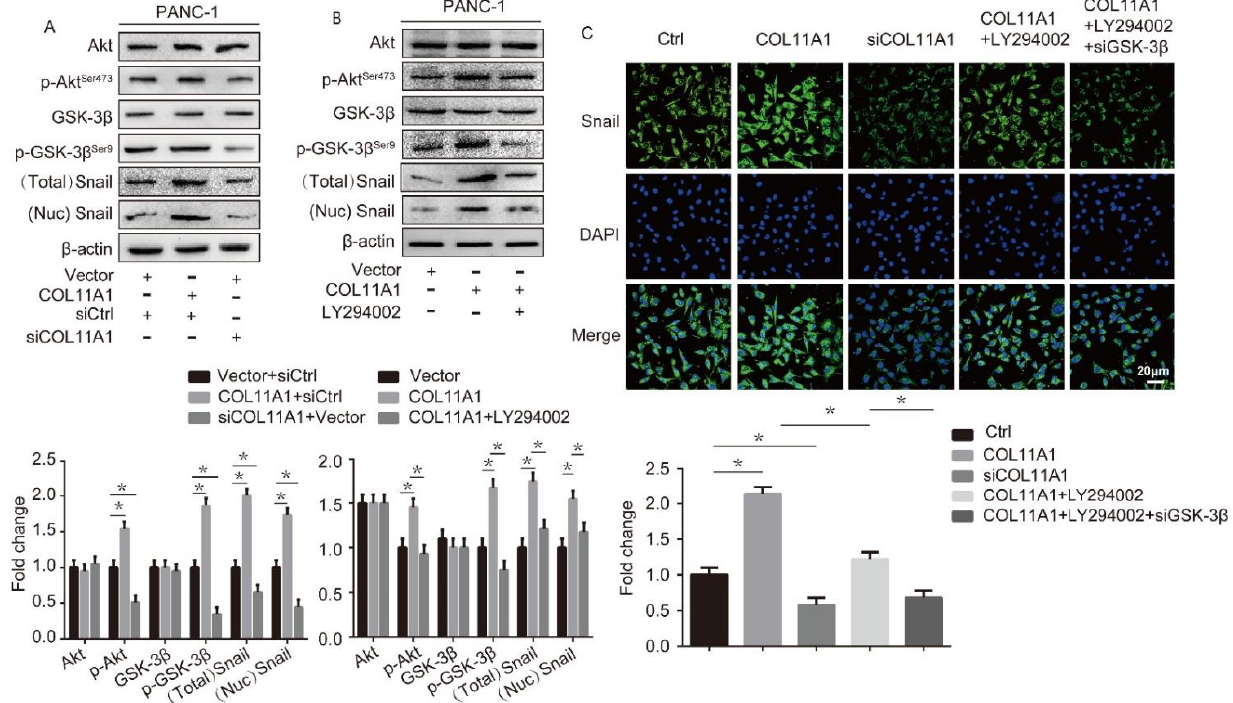
Figure 3. COL11A1 activated the serine-threonine kinase (AKT)/glycogen synthase kinase (GSK)- 3β/Snail signaling pathway : ( A ) expression levels of AKT, GSK- 3β, phosphor (p) -AKT Ser473 ,p-GSK- 3β Ser9 , and Snail in PANC-1 cells transfected with pCMV3-COL11A1 or siCOL11A1 were measured by Western blotting; ( B ) Western blotting results showing the expression levels of AKT, GSK- 3β, p - AKT Ser473 ,p-GSK- 3β Ser9 , and Snail in PANC-1 cells treated with pCMV3-COL11A1 and LY294002; ( C ) immunofluorescence analysis of Snail expression by confocal microscopy in PANC-1 cells transfected with pCMV3-COL11A1, siCOL11A1, and/or LY294002,siGSK- 3β(×100)(n = 3, * p < 0.05).